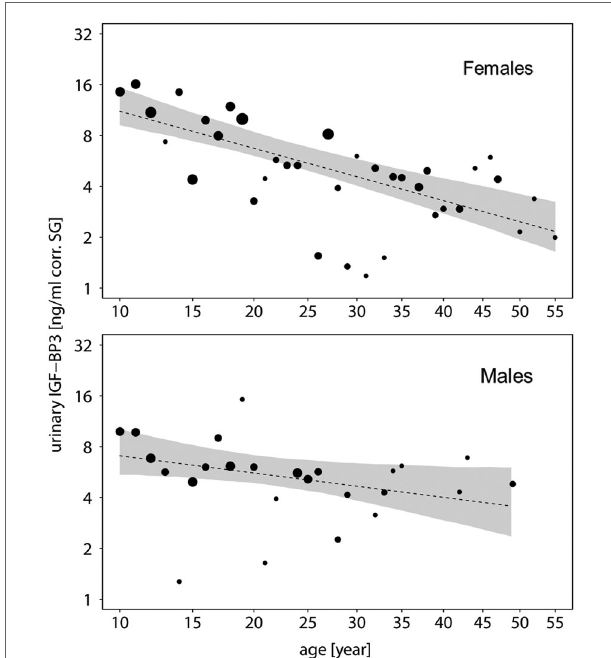
FigUre 3 | Measures of urinary igFBP-3 levels corrected for specific gravity (corr. sg) obtained from female (upper plot) and male (lower plot) bonobos and chimpanzees in relation to their chronologic age (year) . Shaded areas represent bootstrapped 95% confidence intervals for expected urinary IGFBP-3 levels. The area of the circles corresponds to the number of individuals. The y -axis is displayed on a log scale. Sample sizes: N bonobos = 71 (31 males, 40 females), N chimpanzees = 102 (33 males, 69